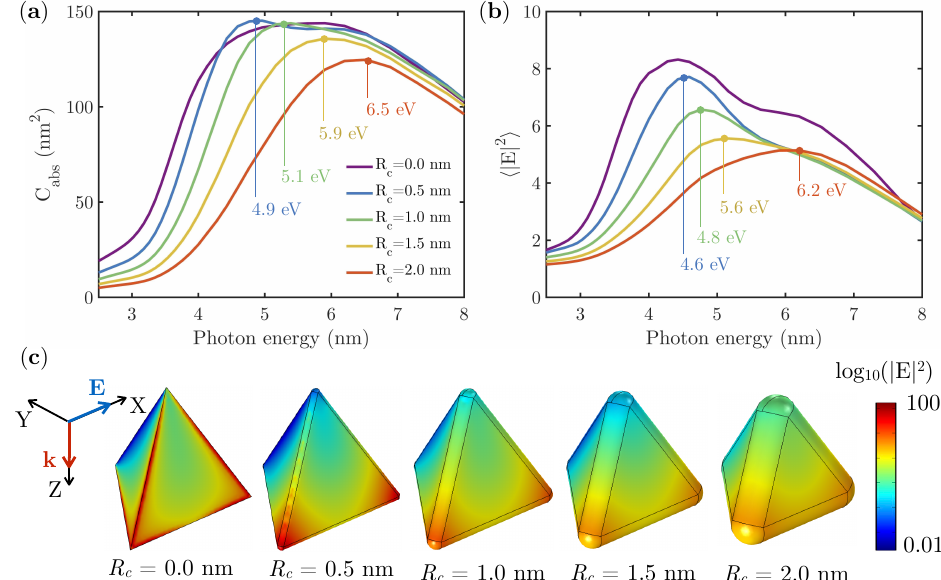
Figure 4. ( a ) Absorption cross-sections ( C abs ) of edge length L = 20 nm Rh NCswith rounded edges and corners with a curvature radii R c varying from 0 (perfect TD) to 2 nm; ( b ) local field enhancement Figure 4. ( a ) absorption cross-sections ( C abs ) of edge length L = 30 nm Rh NCs with rounded edges 2 ) averaged over the TD’s surface; ( c ) local field enhancement in logarithmic scale ( ( E | | and corners with a curvature radii R c varying from 0 (perfect cube) to 15 nm (perfect sphere); ( b ) local surface of the different TD when illuminated with the corresponding resonant 2 ) averaged over the corners and edges (where charge is most concentrated) of field enhancement ( E | | the NC with different R c ; ( c ) local field enhancement in logarithmic scale ( different NCs when illuminated with the corresponding resonant wavelength.